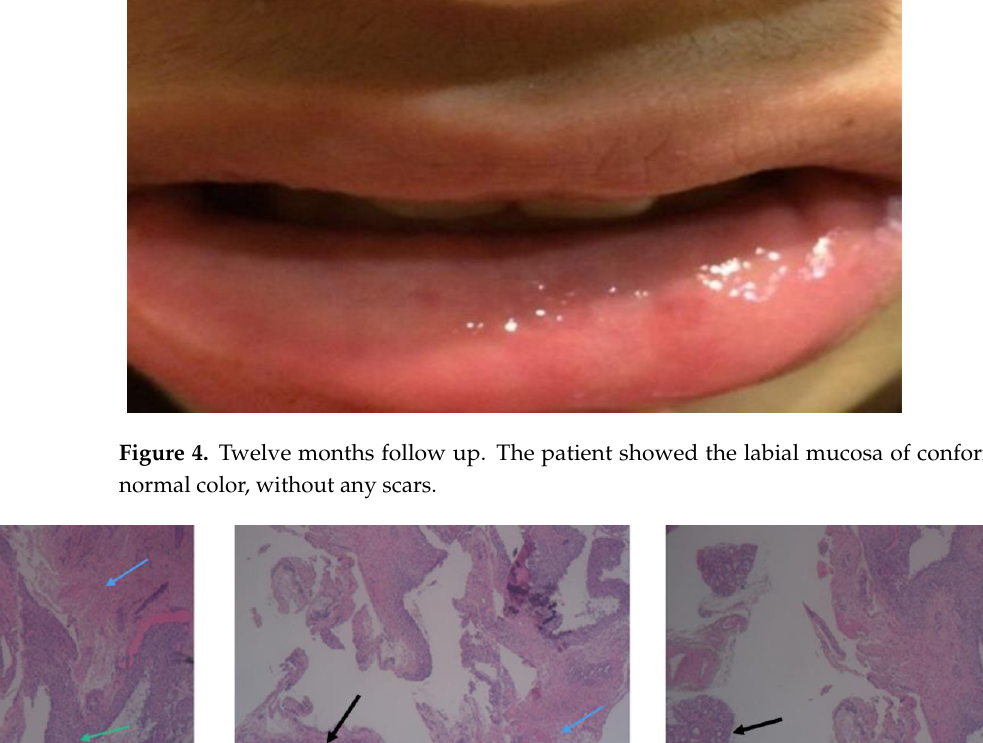
Figure 5. Histological slides of the cyst specimen. Black arrows ( B , C ) indicate benign salivary gland tissue, green arrows ( A , C ) indicate foamy microphages, blue arrows ( A , B ) indicate skeletal muscle fibers.